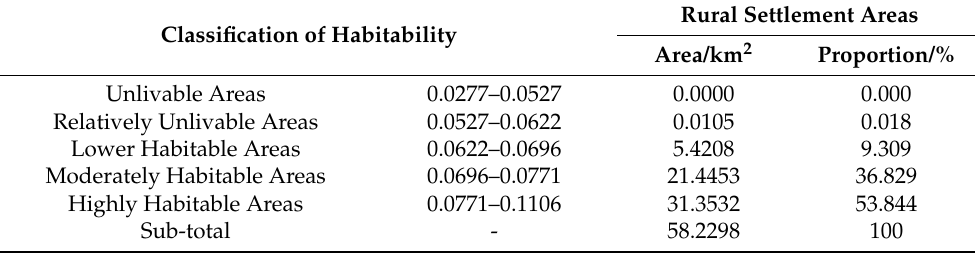
Table 3. Classification Statistics of Livability of Rural